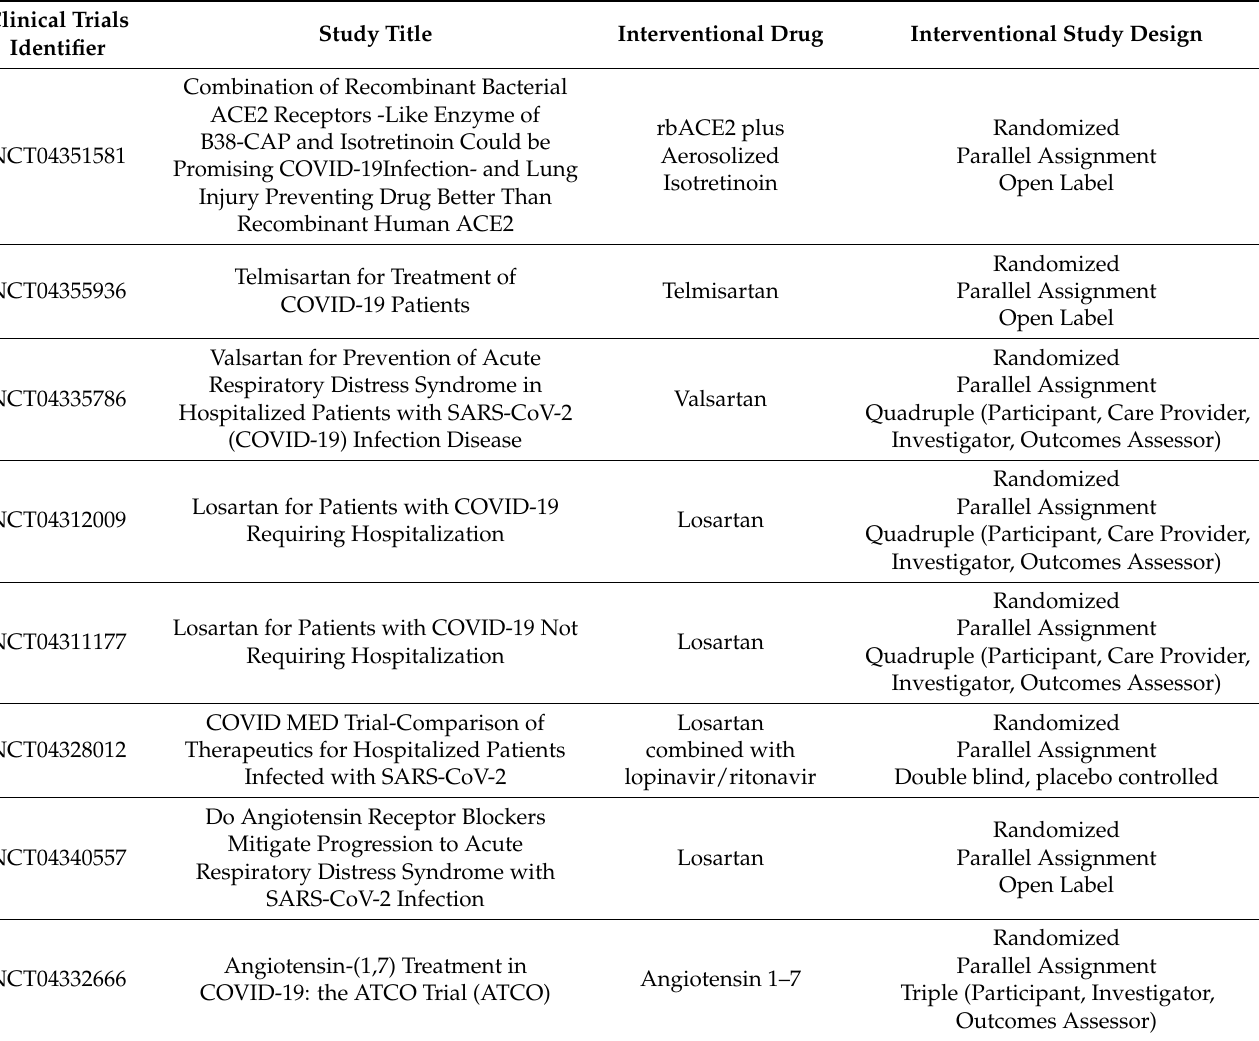
Table 2. Clinical trials evaluating the efficacy of ACE2-ralated therapy and RAS drugs in SARS-CoV-2 pneumonia treatment. Clinical